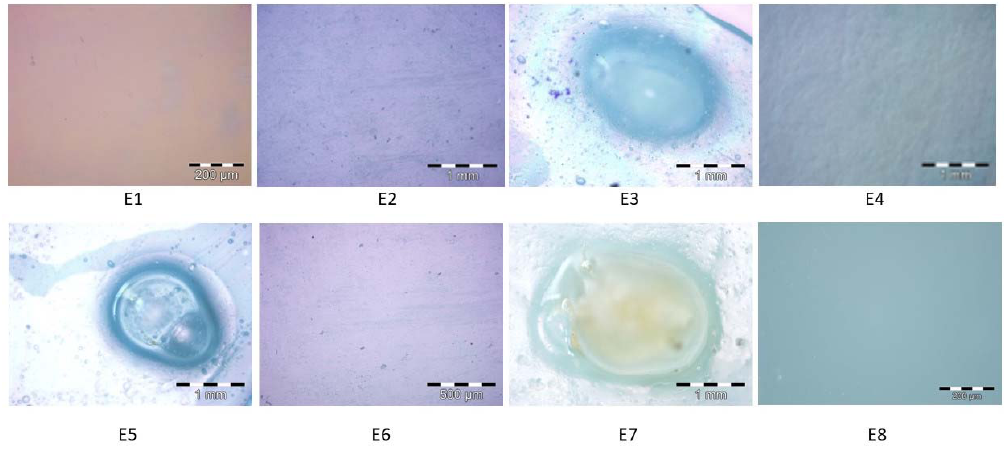
Figure 7. Examples of optical microscopy images of polymeric compositions loaded with essential oils extracted from fennel, peppermint, pine, and thyme